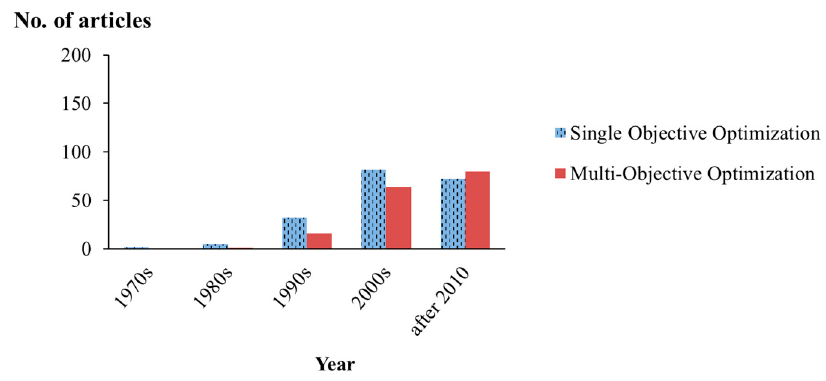
Figure 4. Types of optimization.